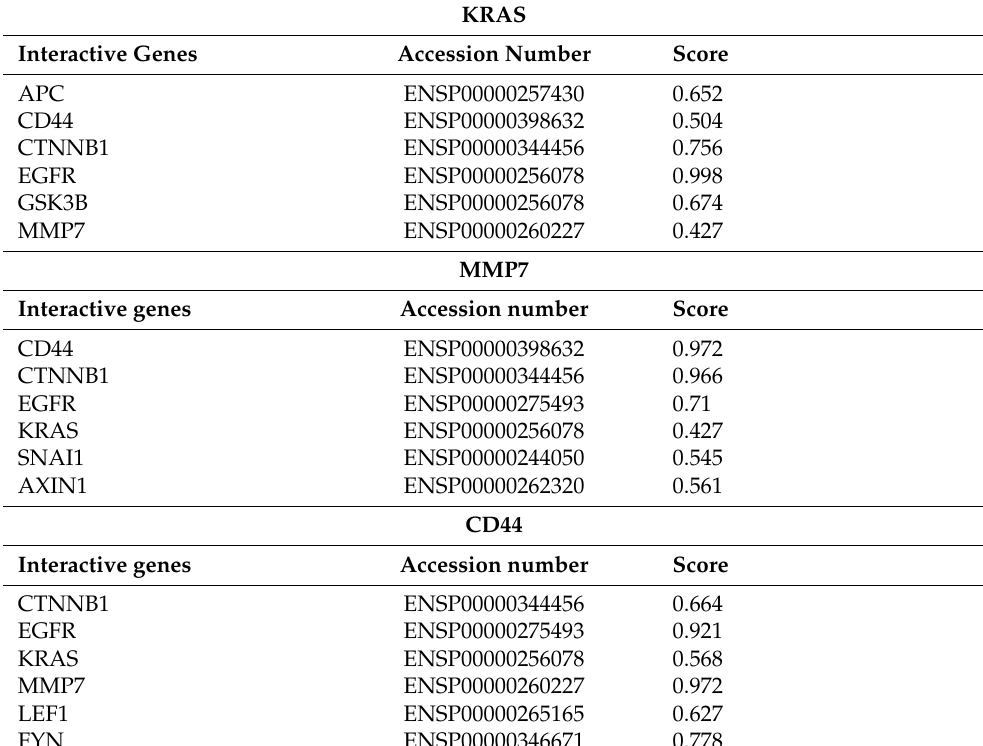
Table 1. Genes interacting with KRAS, MMP7 and CD44 oncogenes.